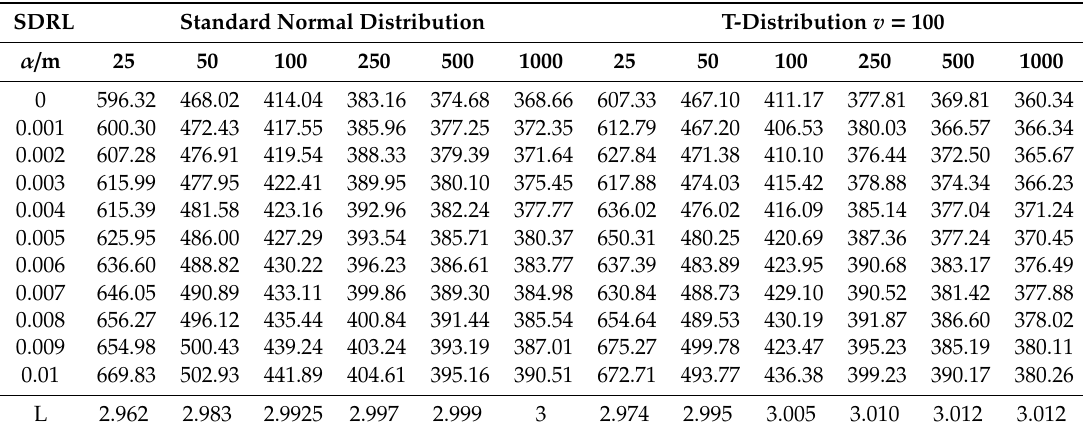
Table 8. SDRL of the Shewhart chart with MAD outlier detection for standard normal and t ( v = 100) distributions.